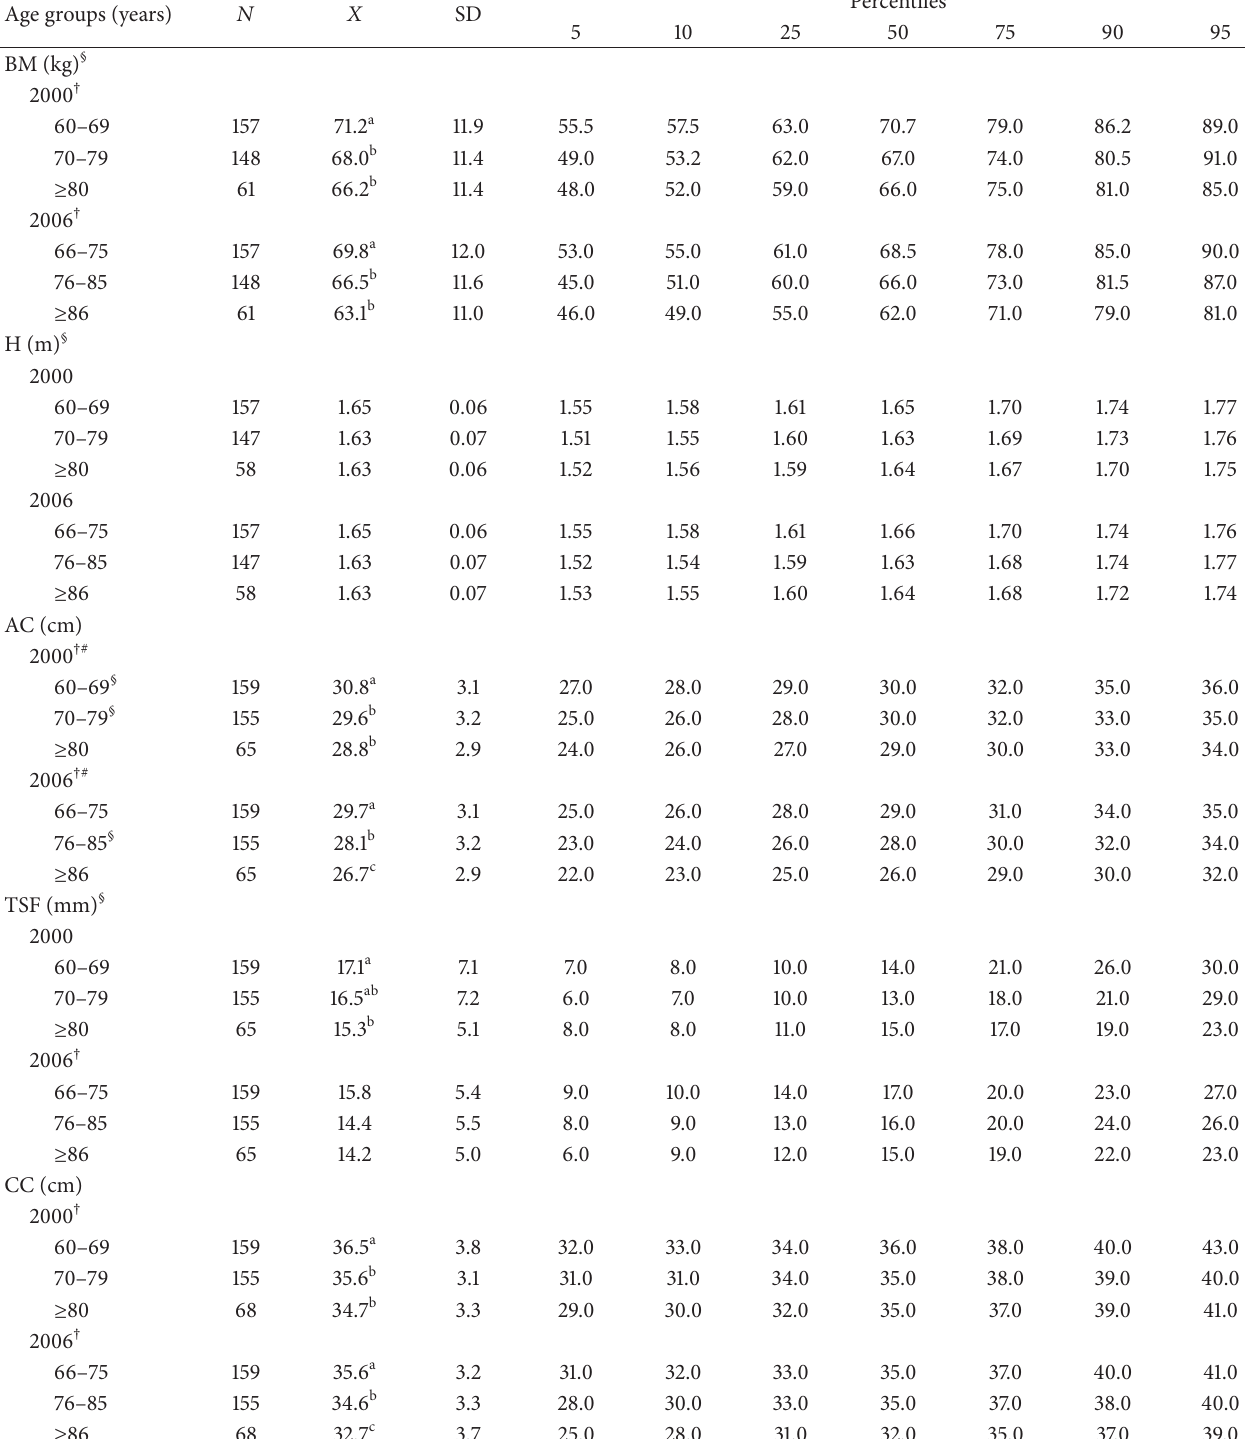
Table 2: Percentile distribution of anthropometric values of men by age group (SABE Survey, S˜ao Paulo, Brazil,